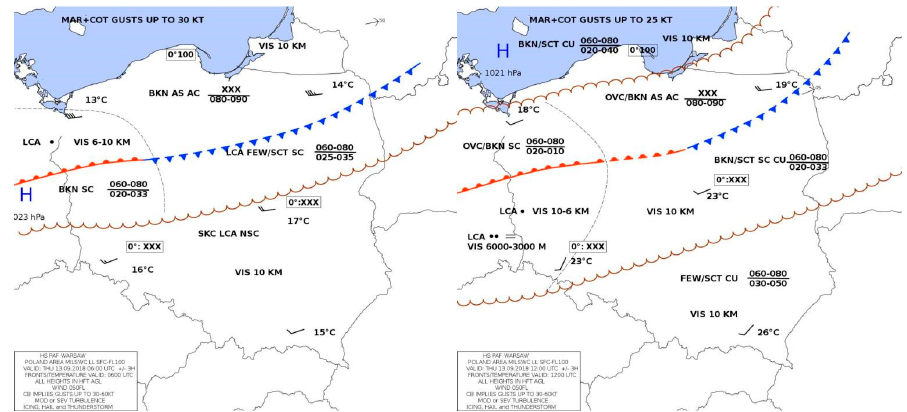
Figure 6. Graphical forecast for Poland for September 13, 2018, at 06:00 and 12:00 UTC ( ± 3 h) (based on Reference [43]).